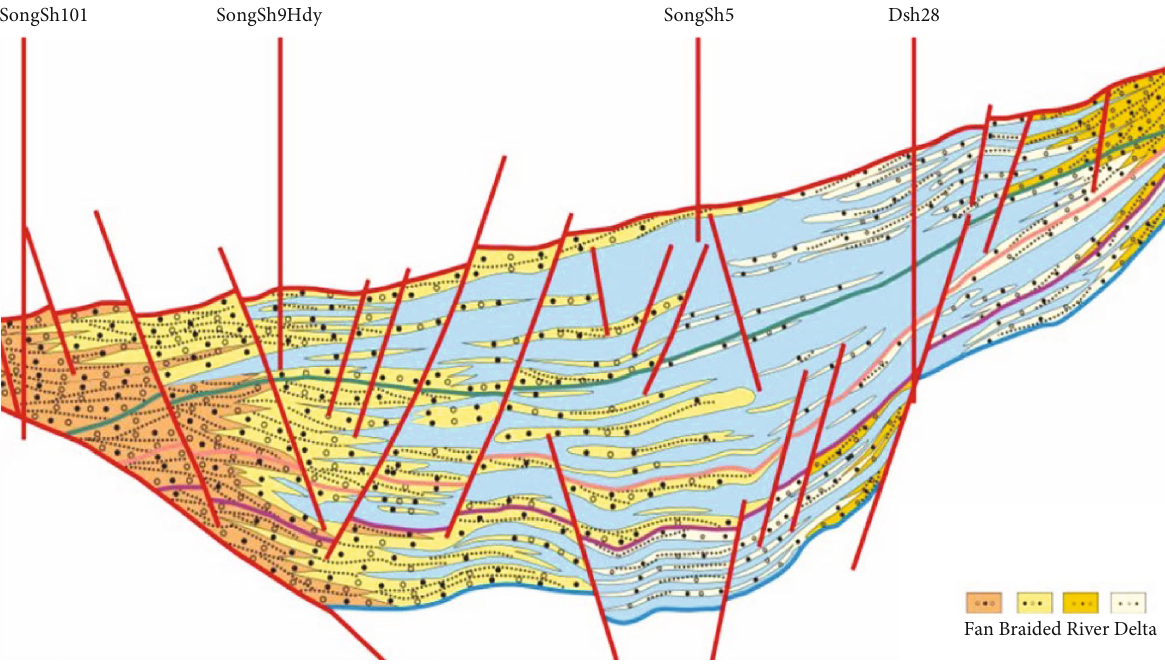
Figure 7: Sedimentary facies pro fi le of Songsh101-DSh28